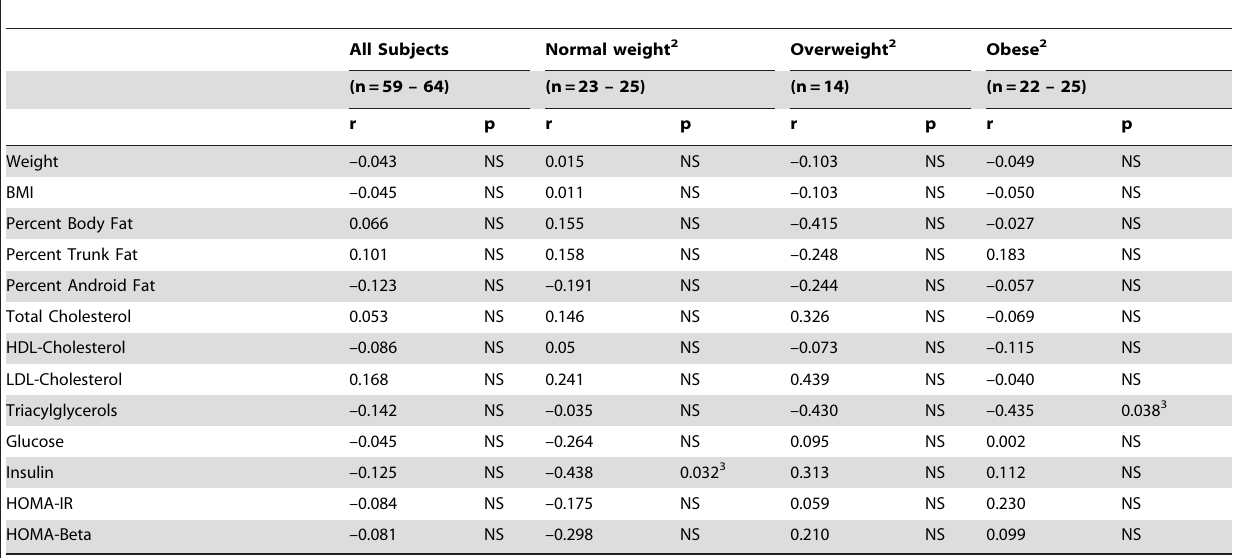
Table 3. Partial correlations of changes in variables due to overfeeding related to baseline fasting serum adiponectin, after control for age 1 .